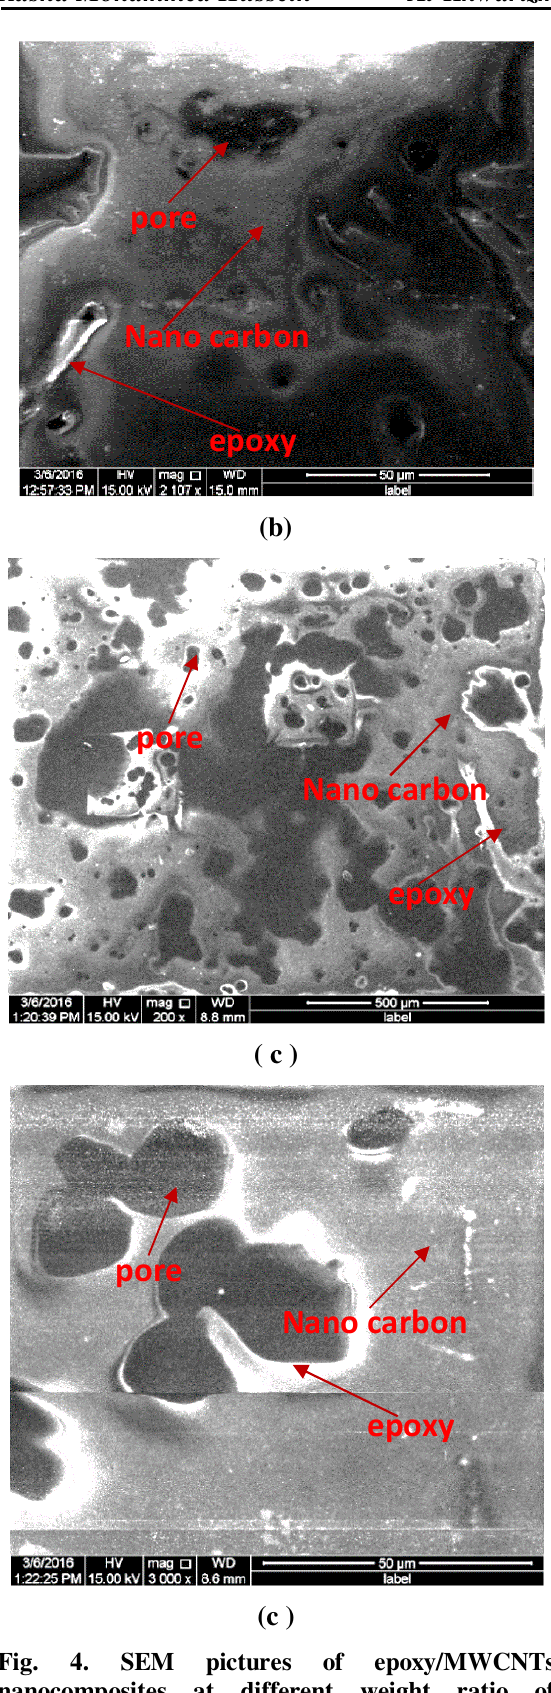
Fig. 4. SEM pictures of epoxy/MWCNTs nanocomposites at different weight ratio of MWCNTs;( a )with 0.1wt.% MWCNTs,( b )with 0.5wt.%MWCNTs, and ( c ) with 1 wt.% MWCNTs .